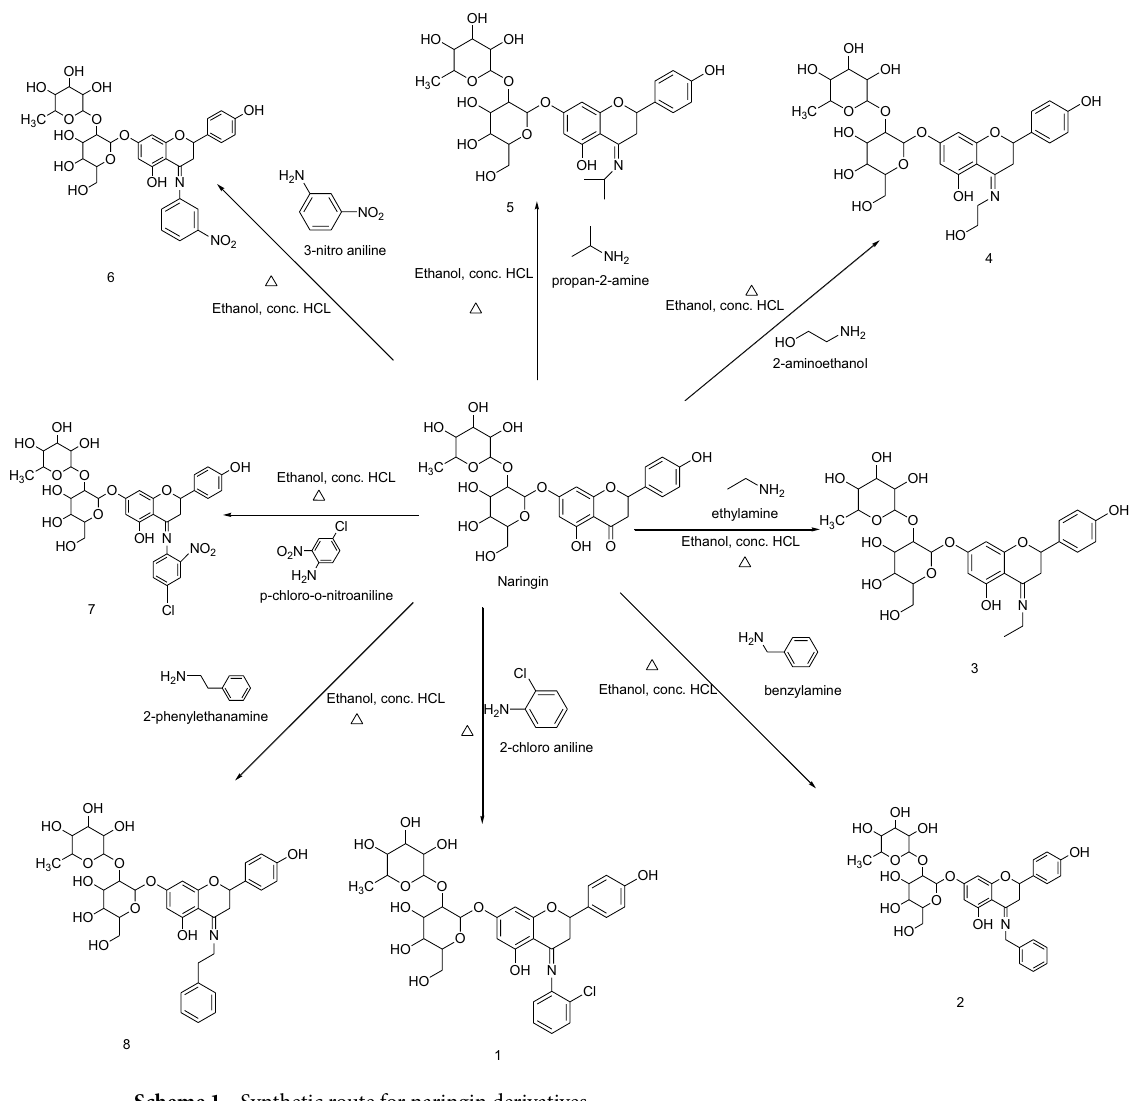
Scheme 1. Synthetic route for naringin